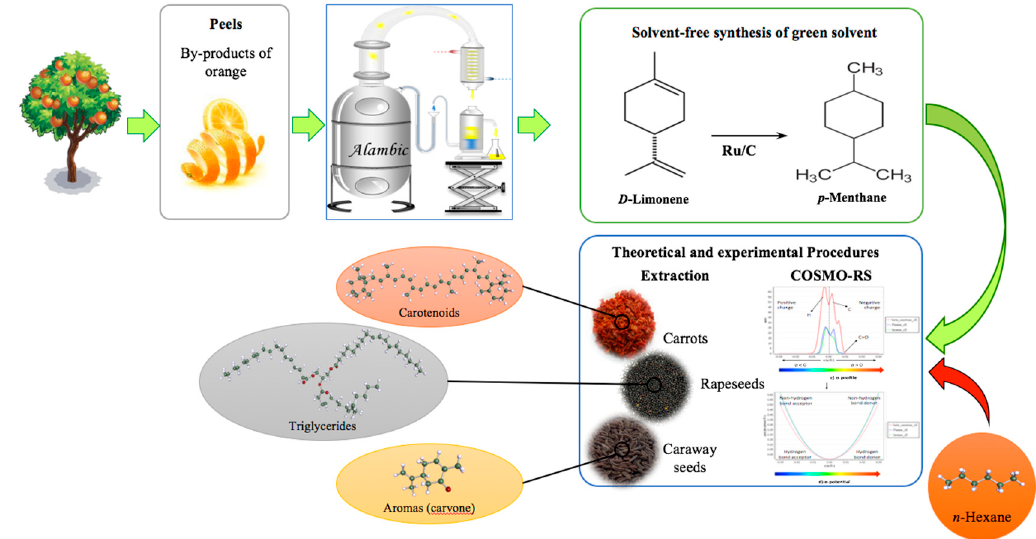
Figure 1. Summary of the followed study protocol. COSMO-RS—conductor-like combination of quantum chemistry coupled with statistical